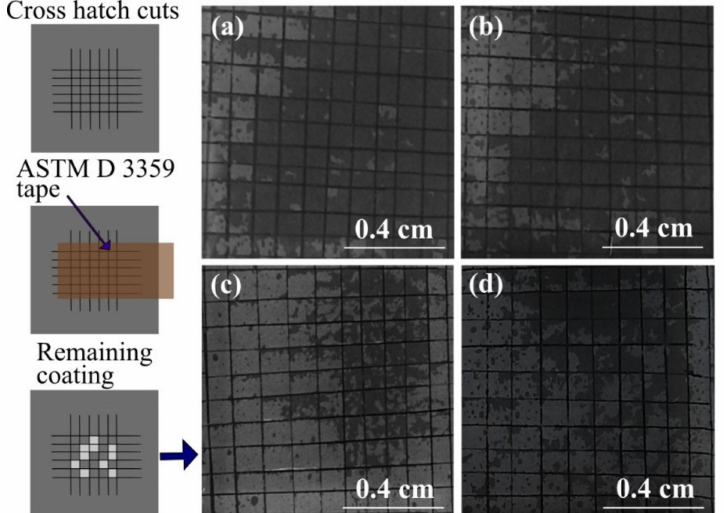
Figure 4. ASTM D 3359 tape adhesion test for PPy films on FTO substrates. The photos show the coatings remaining on the substrate after peeling off the tape. The films were synthesized at different potentials: ( a ) 0.9 V, ( b ) 1.0 V, ( c ) 1.1 V, and ( d ) 1.2 V. The electric charge supplied was 21 mC/cm 2 in all